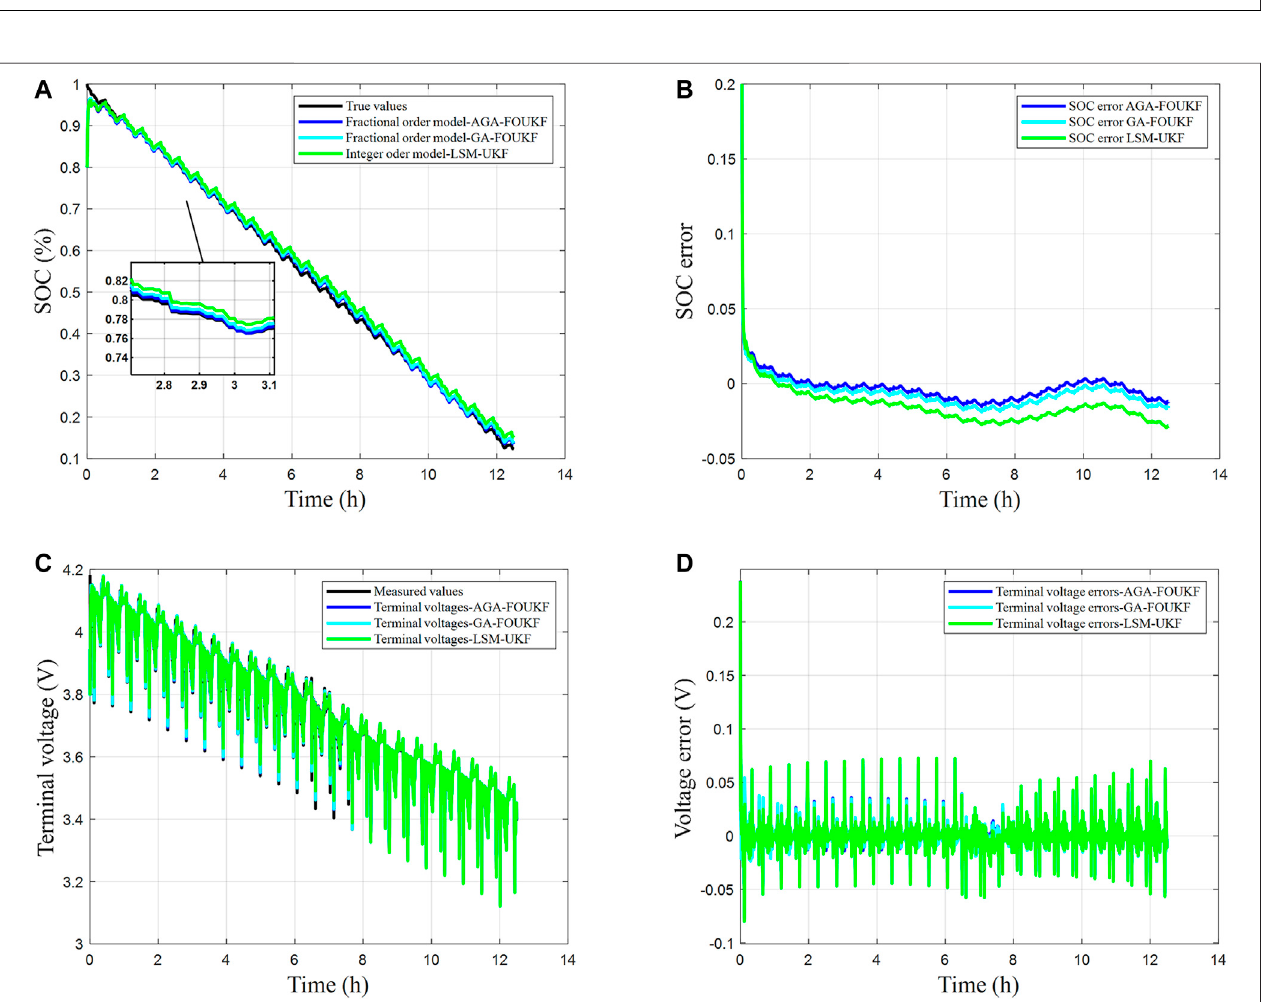
FIGURE 10 | The results of dynamic discharge experiment. (A) SOC estimation result; (B) the errors of SOC estimation; (C) terminal voltage estimation result; (D) the errors of terminal voltage.